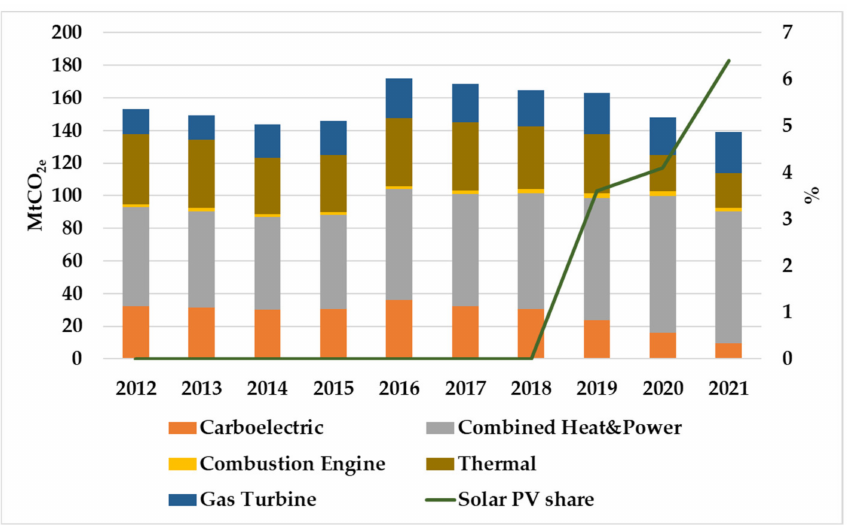
Figure 2. Evolution of PV solar energy share in the generation matrix and of GHG emissions by type of technology, 2012–2021. Source: own elaboration with information from